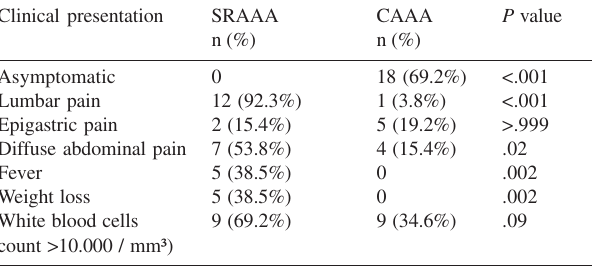
Table 2 - Clinical presentation and preoperative exams in 13 patients with sealed rupture AAA (SRAAA) and in